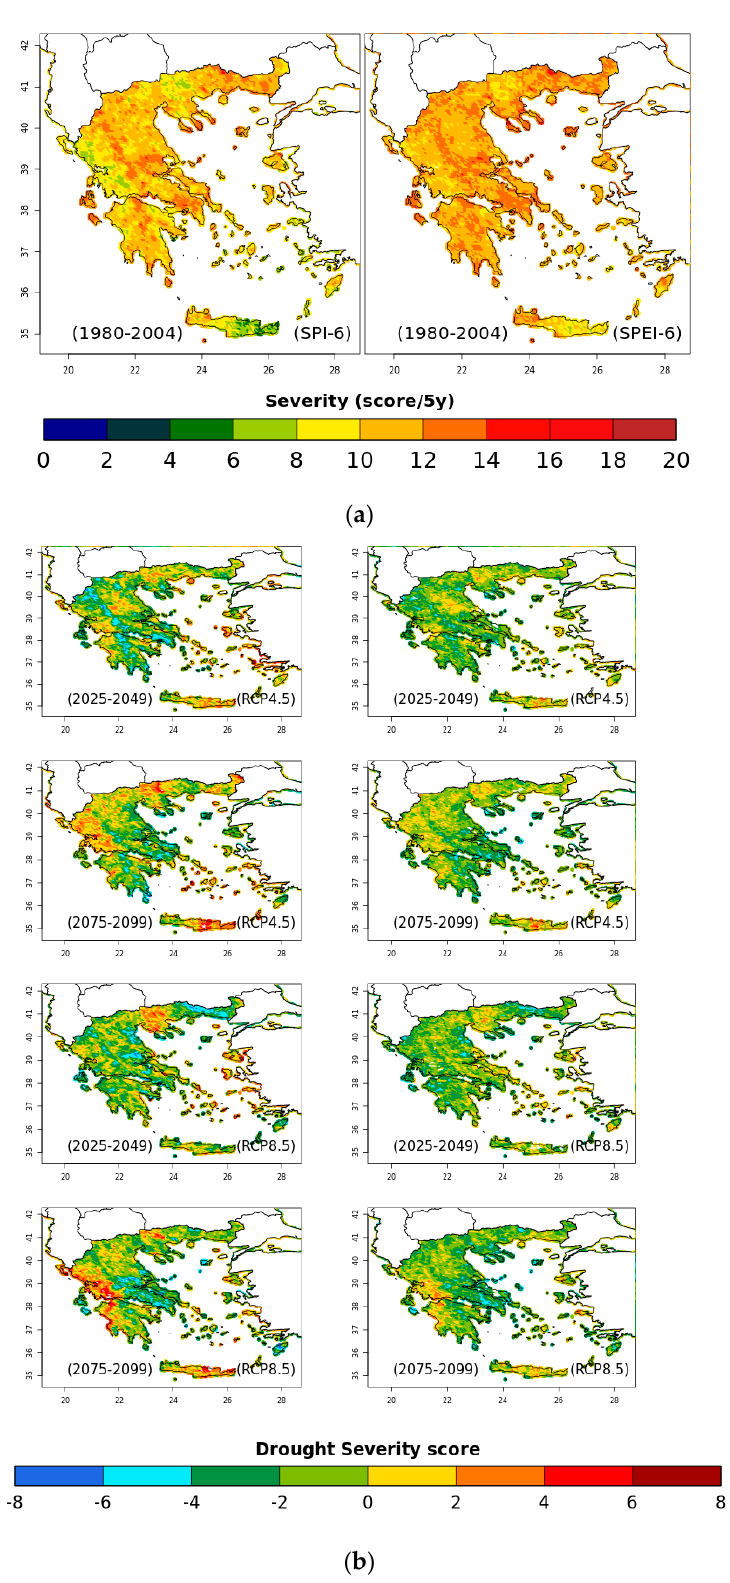
Figure 5. ( a ) Drought Severity as the averaged values obtained for the entire reference period (1980–2004) for the SPI and the SPEI indices computed at a 6 − month timescale. ( b ) Changes in the severity for the 6 − month SPI and SPEI for the near future period (2025–2049) and the far future (2075–2099) relative to the reference period (1980–2004) under RCP4.5 and RCP8.5.